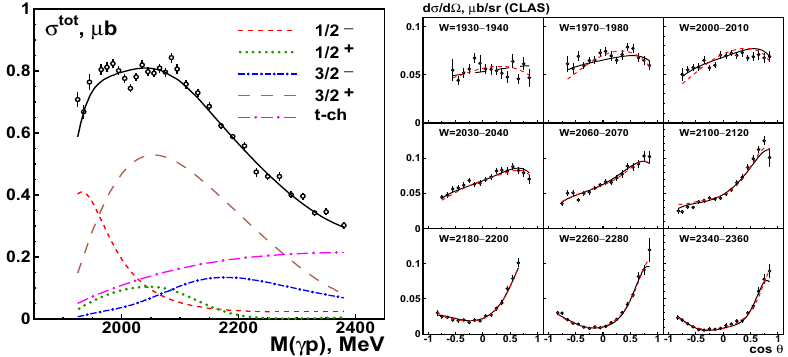
Figure 2. Description of the γ p → η (cid:2) p di ff erential cross section from CLAS [8] and the contribution of the leading partial waves to the total cross